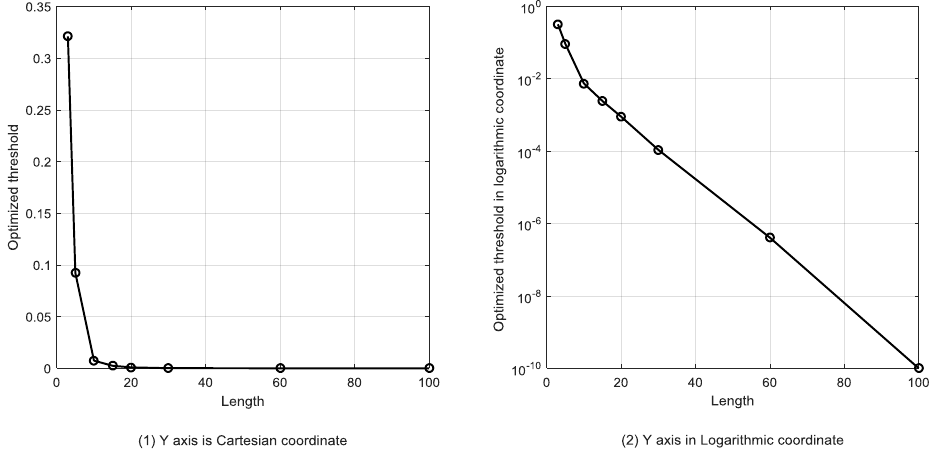
Figure 17. Optimized thresholds for different lengths of the sequence.